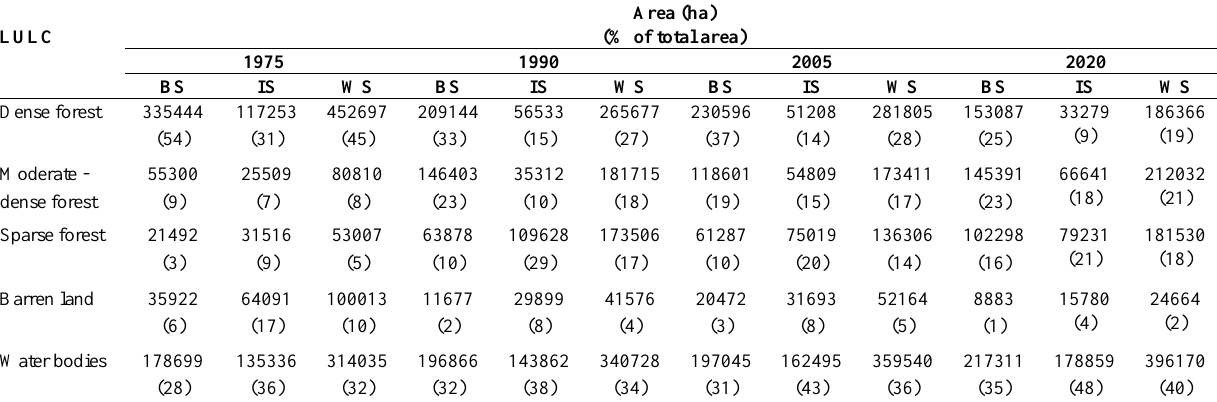
Table 2. LULC of Sundarbans from 1975 - 2020. Here, BS=Bangladesh Sundarbans, IS=Indian Sundarbans, WS=Whole